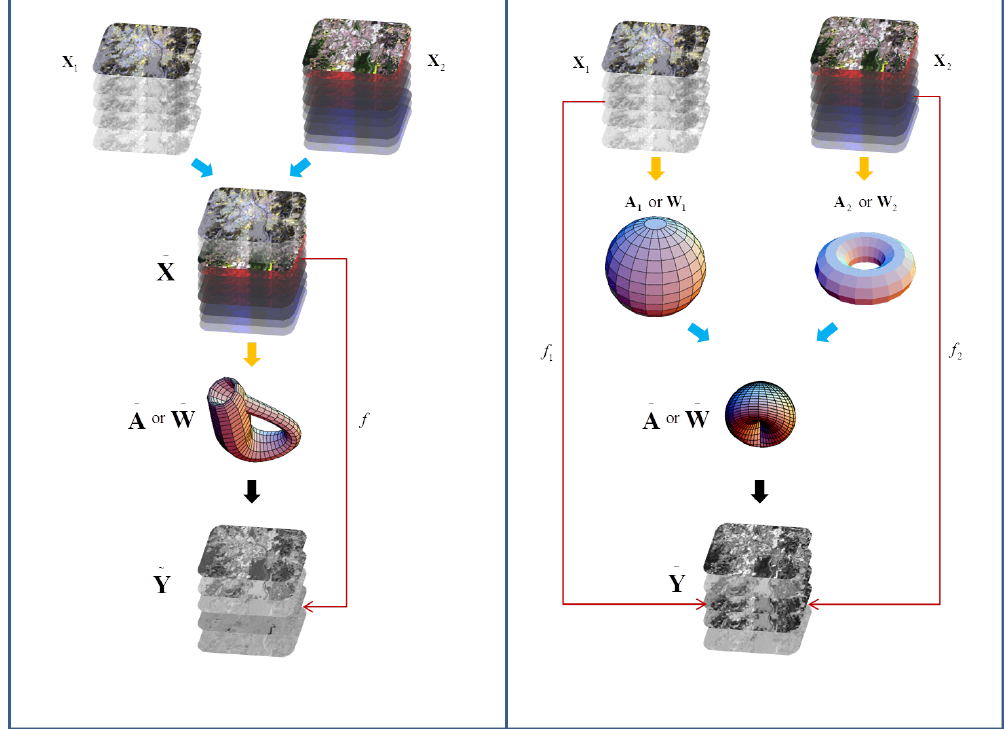
Figure 1. Frameworks of manifold learning fusion techniques. Left: the data alignment fusion; Right: the manifold alignment fusion. The blue arrow indicates the fusion step. The yellow arrow indicates where the modeling of manifold takes place. The black arrow indicates the feature extraction. X i : i th data source; A or W : mathematical modeling of manifolds; Y : fused feature; f : the learned projection. ˜ · : a fusion of certain